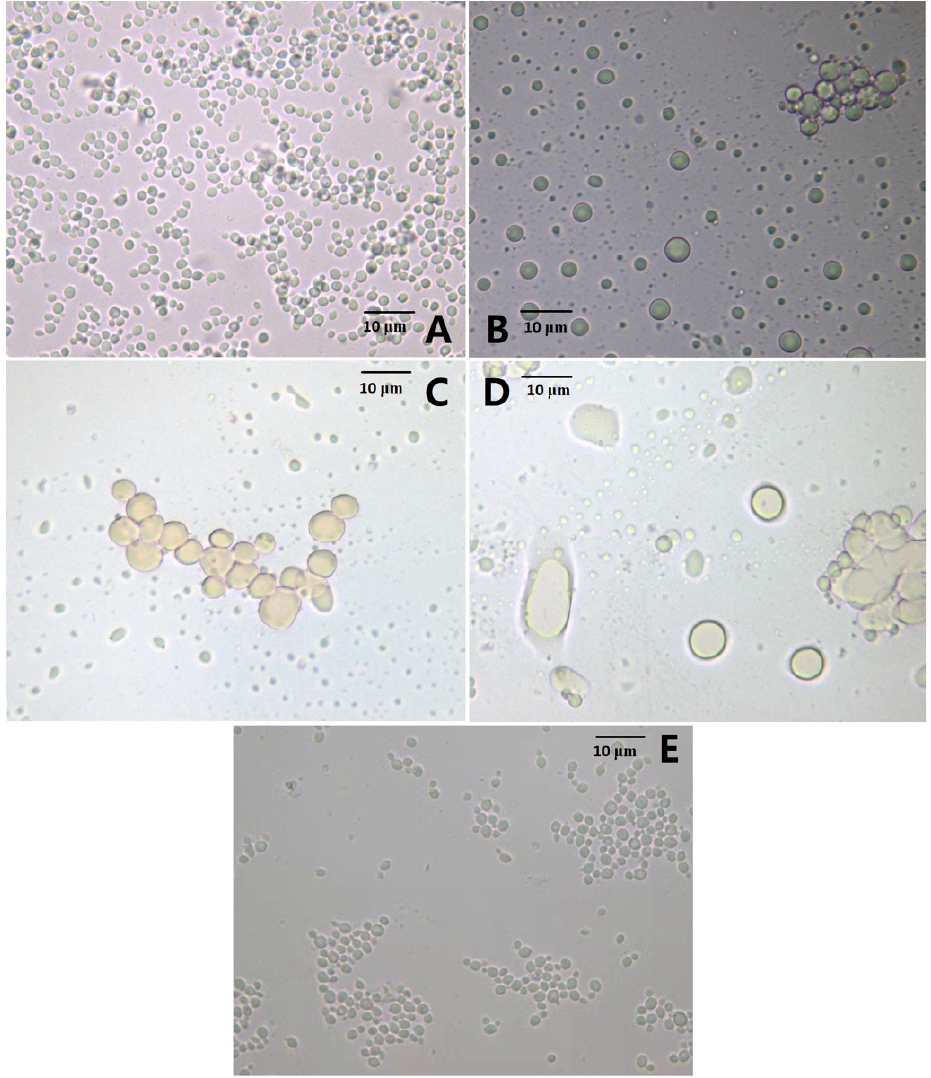
Figure 1. Cell morphology of the P. pastoris expressing the antibacterial peptide (AMP). ( A ), the cell before methanol treatment; ( B ), the cell after methanol treatment for 3 h; ( C ), the cell after methanol treatment for 6 h; ( D ), the cell after methanol treatment for 9 h; ( E ), the cell expressing the aflatoxin-detoxifizyme (ADTZ) after methanol treatment for 9 h.